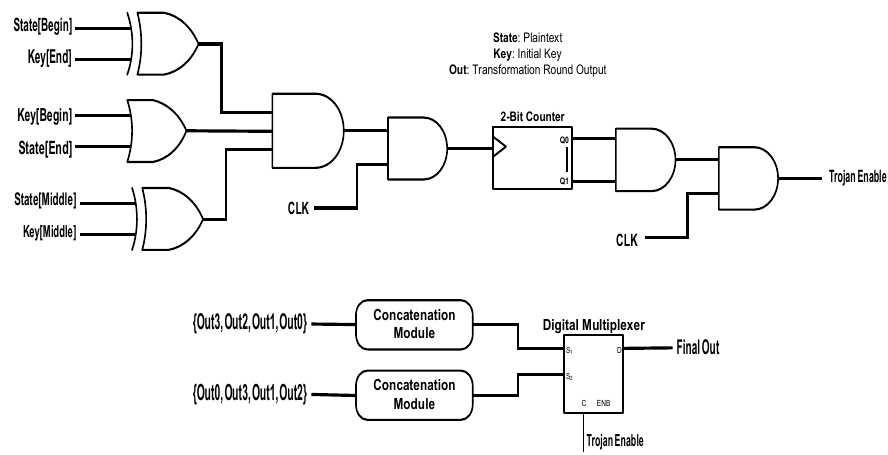
Figure 2. Attack 1: The hardware Trojan circuit for malicious manipulation of the output of the intermediate transformation round.